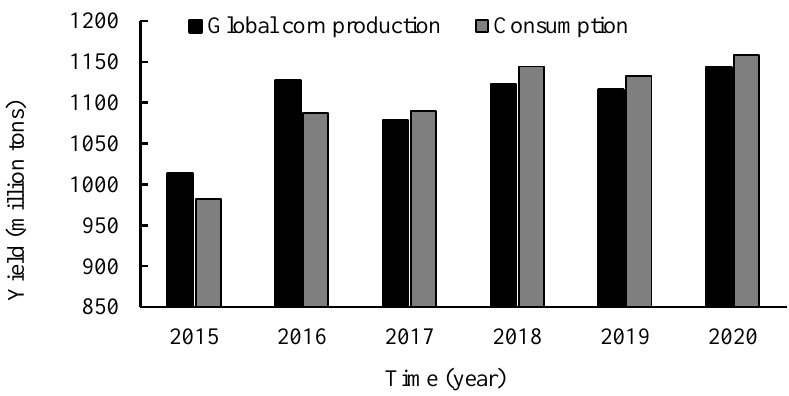
Figure 1. Map of global corn production .